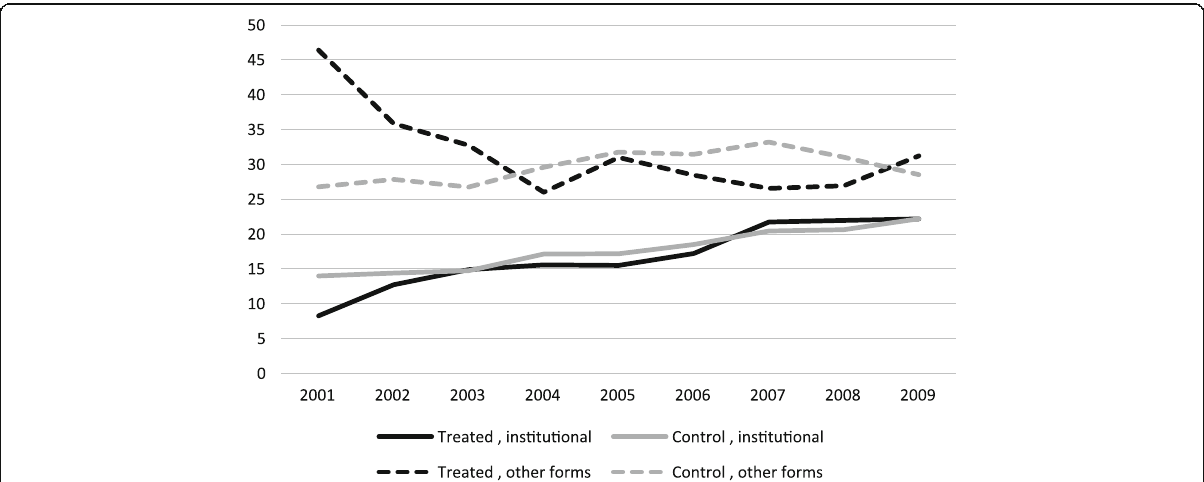
Fig. 4 Evolution of childcare use by type of care in treated and control cantons. Source: Swiss Labour Force Survey 2001 – 2009. The sample is restricted to mothers between 20 and 50 years of age with at least one child between 0 and 3 years of age